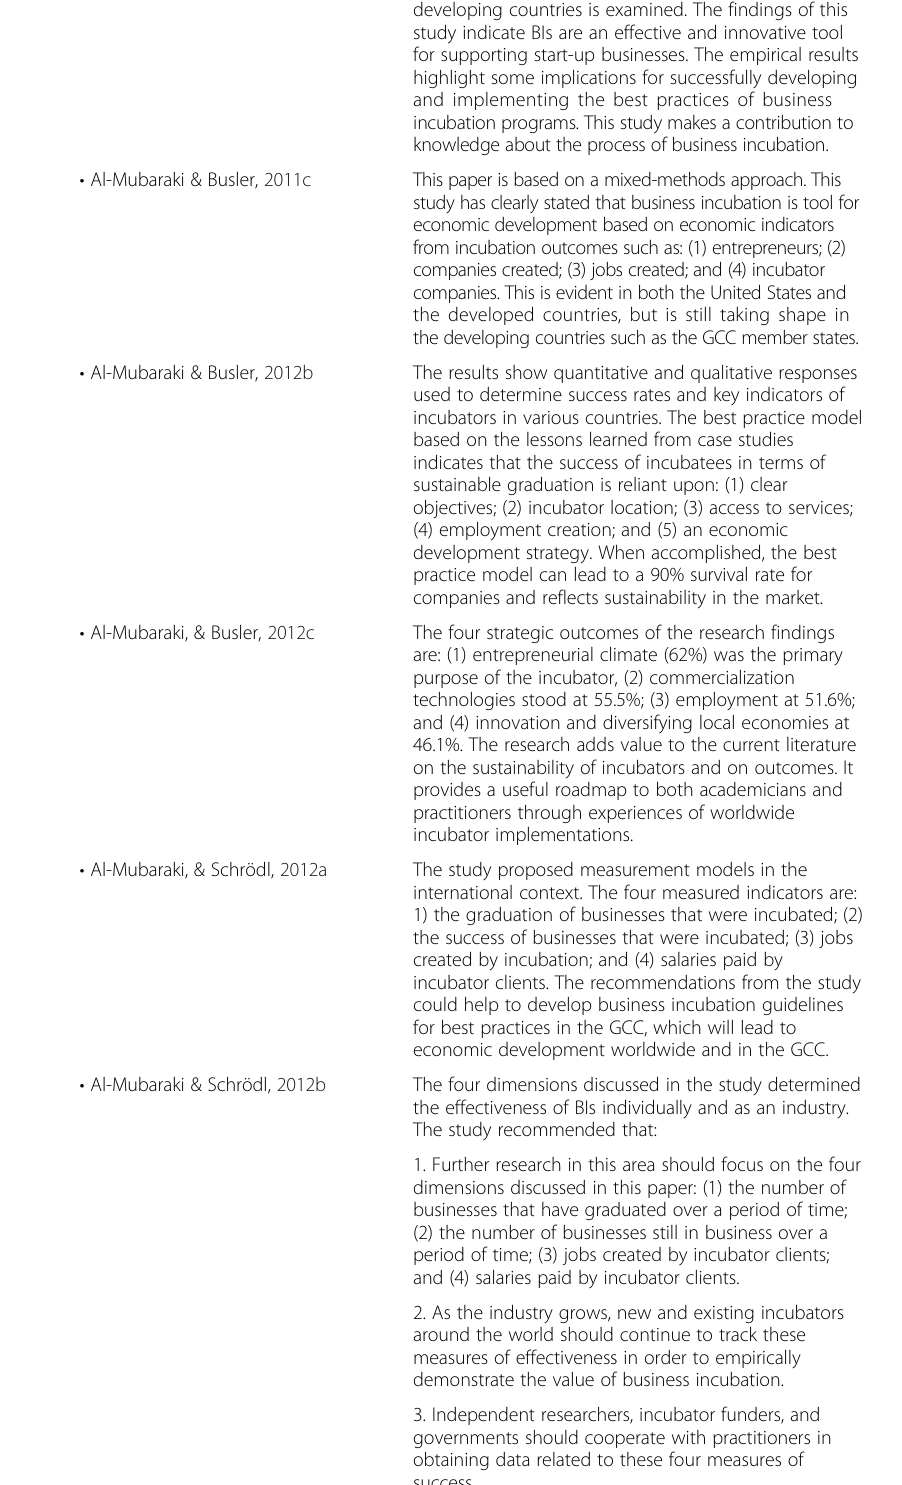
Table 1 Incubators: evidence from the literature